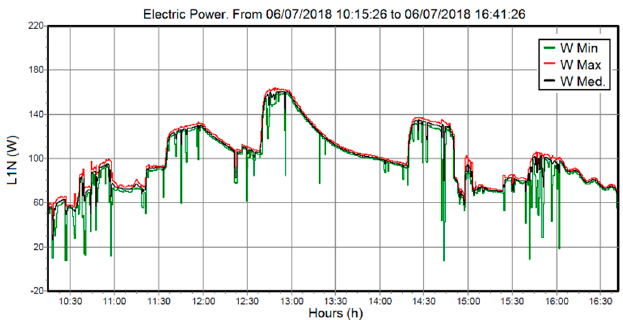
Figure 4. Electric power evolution obtained throughout the entire experiment.